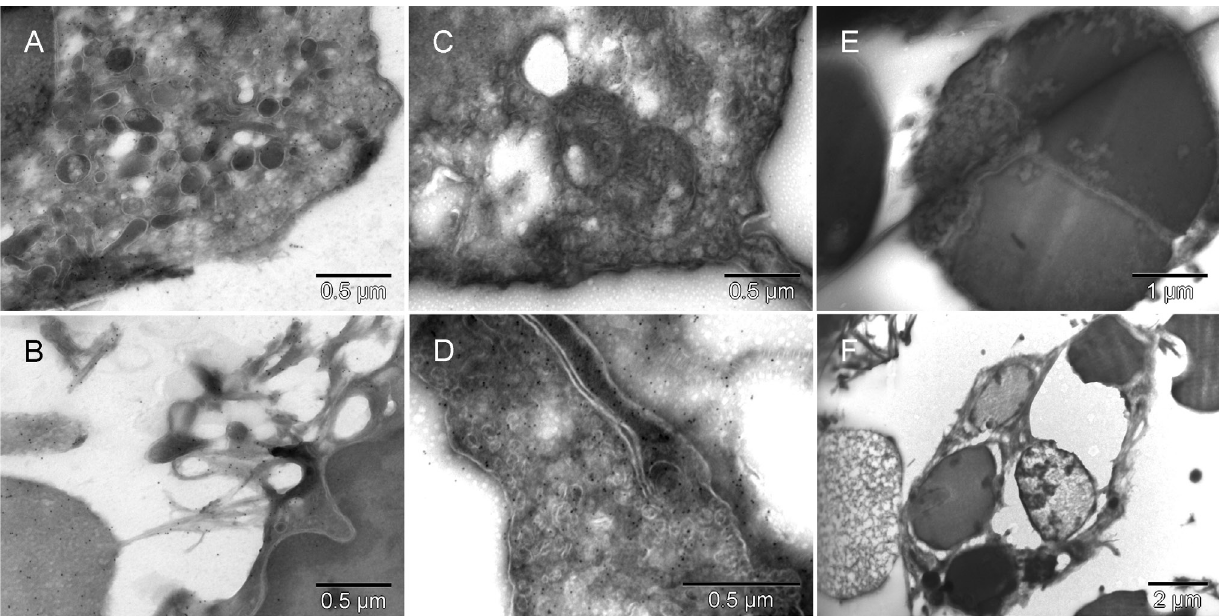
Figure 5. Cells of graft origin labeled with GFP under ubiquitin promoter. GFP-specific label was present in erythroblasts [ A ], primitive erythrosomes like the one separating from the cell that made it (left lower corner in [ B ]), platelets [ C ] and in EC [ D ]. Morphologically interesting cells, erythroblast [ E ] and perishing hemangioblast [ F ], stained with nonspecific antibody are shown at low magnification (they had no gold grains). The erythroblast was entirely consumed by a successful incremental conversion into at least three erythropoietic vesicles [ E ] and the cell with ambivalent phenotype [ F ], possibly hemangioblast, contained three internal vesicles resembling erythrosomes and two of comparable size that appeared to be failing as erythrosomes (partially electron lucent